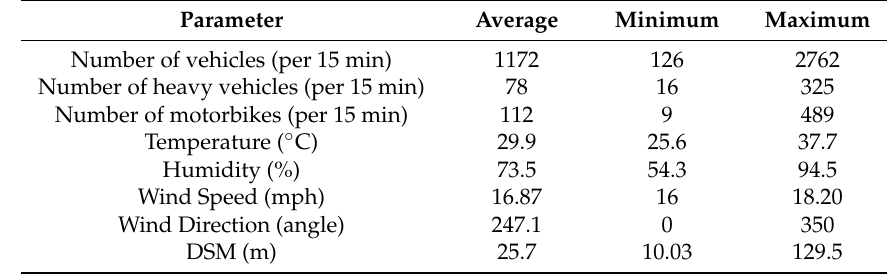
Table 1. Summary statistics of traffic CO predictors.